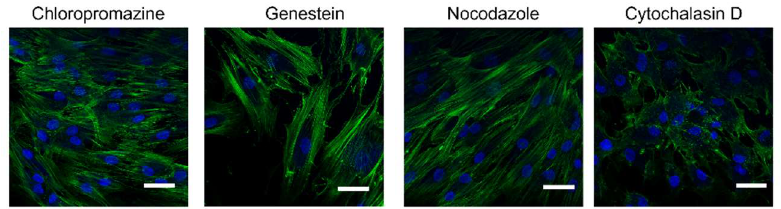
Figure 9. Confocal microscopy images of hMSCs showing the F-actin filaments morphology after treatment with each one of the inhibitors (Chlorpromazine, Genistein, Nocodazole, Cytochalasin D) for 30 min. Nuclei were stained by Hoechst33258 and appear blue, F-Actin was stained with FITC-phalloidin and appears green (scale bar = 20 µm).